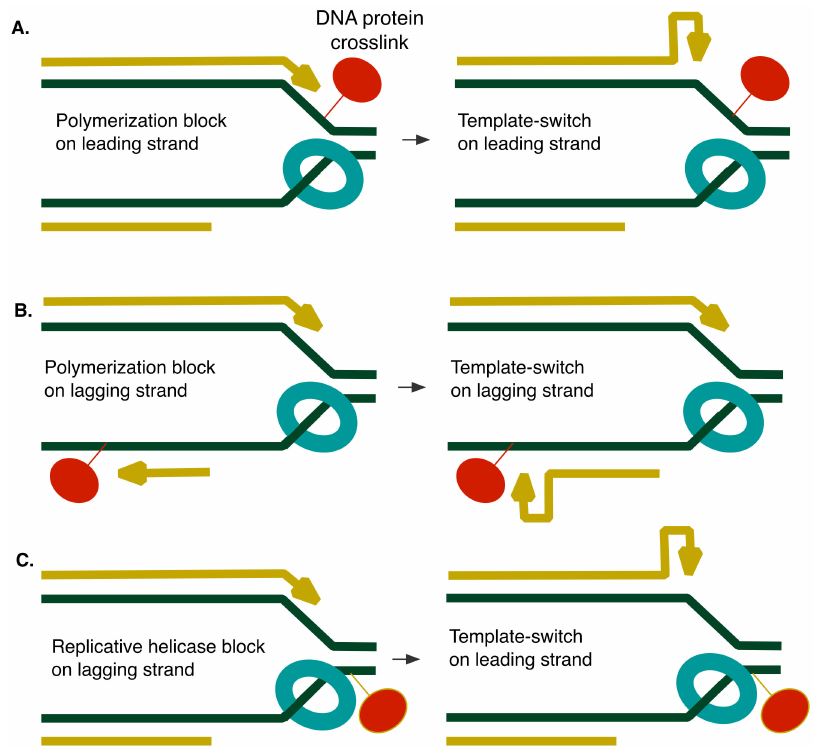
Figure 10. DPC blocks at the replication fork and consequential template-switching. ( A ) Polymerization block (red) on the leading strand promotes template-switching on the leading strand. ( B ) Polymerization block (red) on the lagging strand promotes template-switching on the lagging strand. ( C ) Fork helicase block (red) on the lagging strand promotes template-switching on the leading